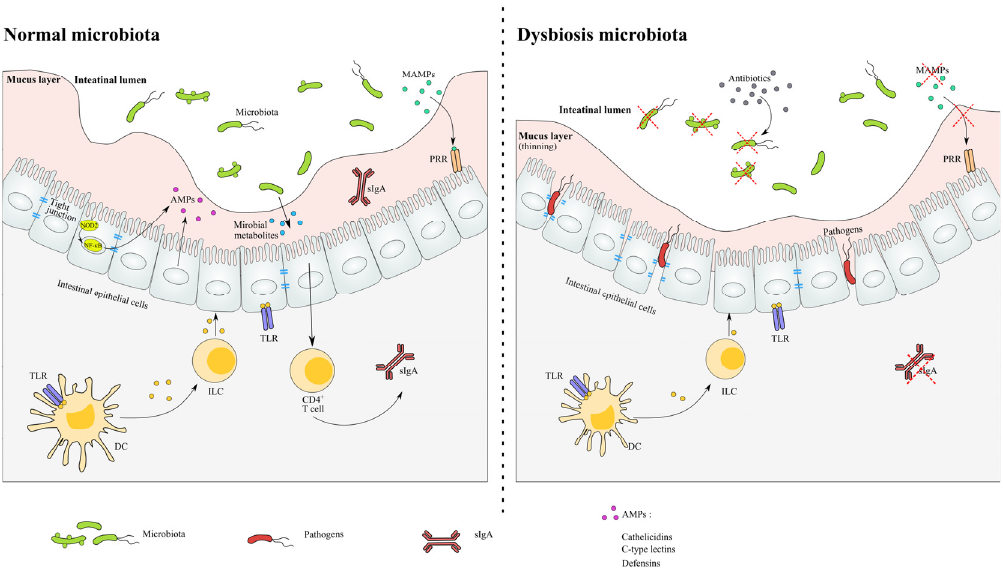
Figure 2. The impact of antibiotics on the microbiota, metabolites and